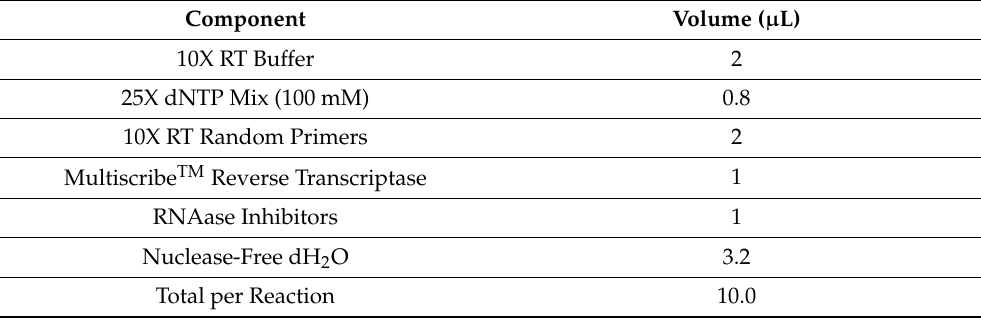
Table 1. 2XRT Master Mix (for 1 reaction).